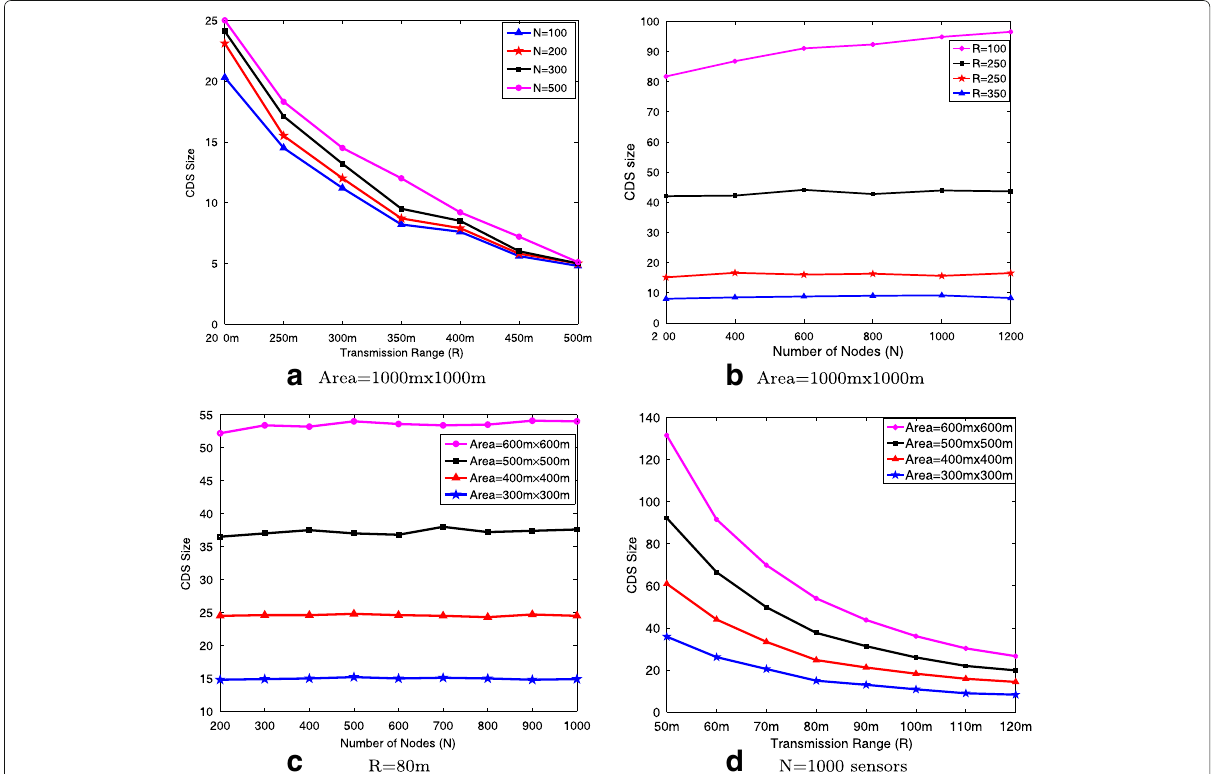
Fig. 4 The performance of our algorithm. a Size of CDS with a different value of N when R varies between 200 and 500 m. b Size of CDS with the different value of R when N changes from 200 and 1200 sensors. c Size of CDS with fixed R = 80 m when N varies between 200 and 1000 sensors. d Size of CDS with fixed N =1000 sensors when R changes from 50 to 120 m